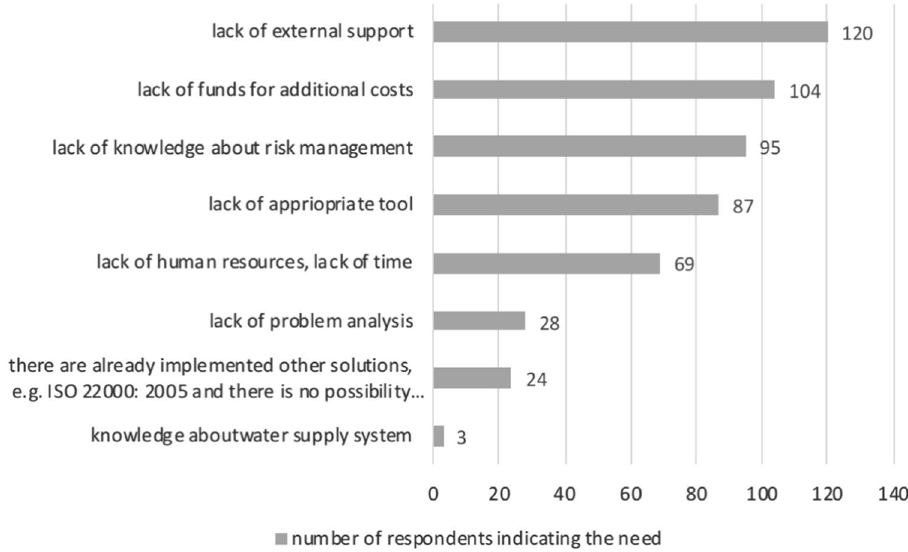
Fig. 5 Distribution of